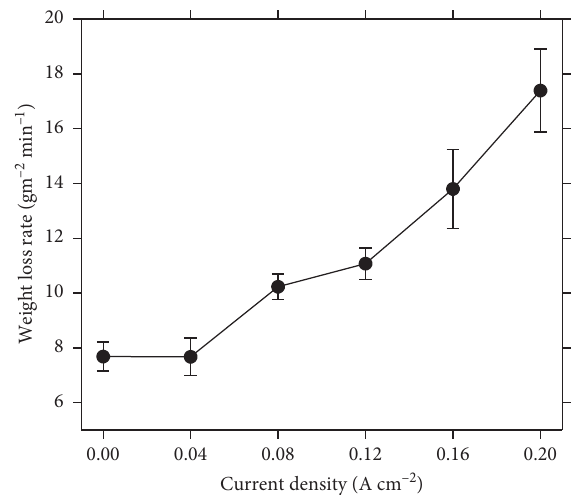
Figure 10: Variation of the dynamic pickling rate with current density in 300g L − 1 H 2 SO 4 solutions at 75 °